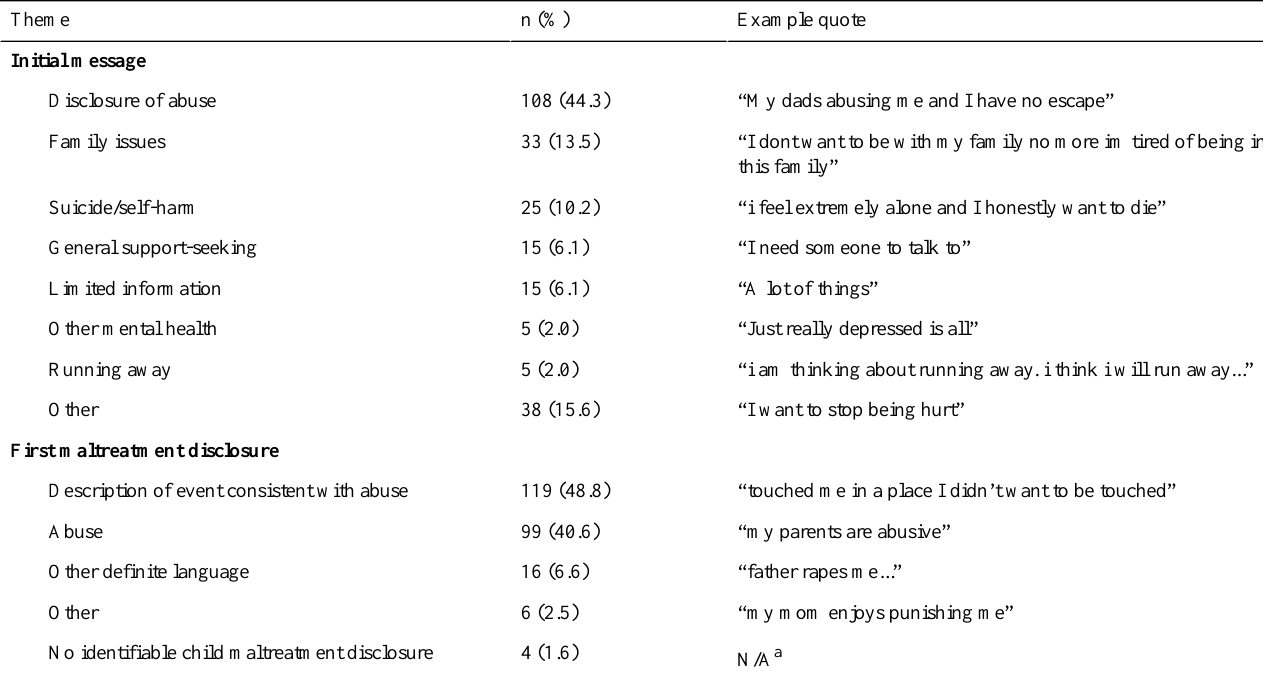
Table 2. Distribution of content of initial message and first maltreatment disclosure (N=244).